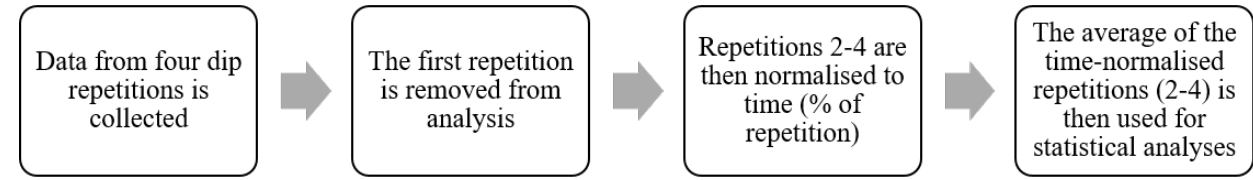
Figure 2. A flow chart representing the normalization procedures for each dip repetition and varia-